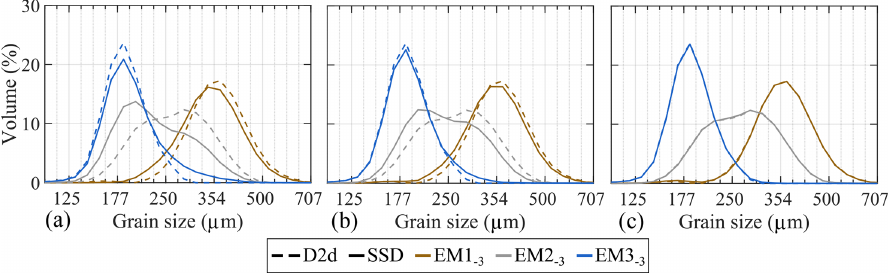
Figure 12. ConD2d (a) , CcD2d (b) , and ArD2d (c) 3EM solutions determined for the aeolian dune dataset. The SSDs are displayed as grain size distributions (solid lines) and compared to grain size distributions of the D2d 3EM solution (dashed lines).